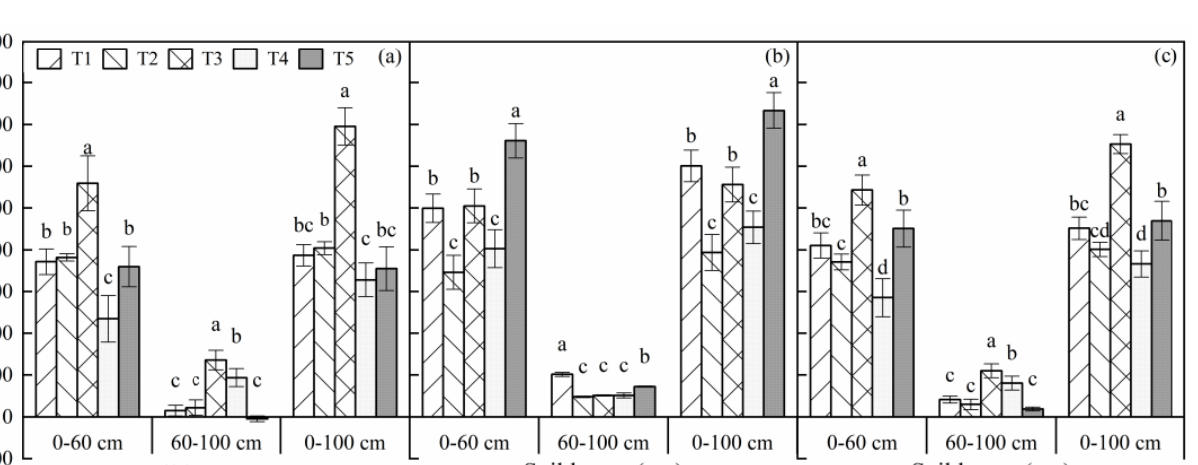
Table 3. Salt accumulation rate in different soil layers inside and outside film for treatments (%). Treatment